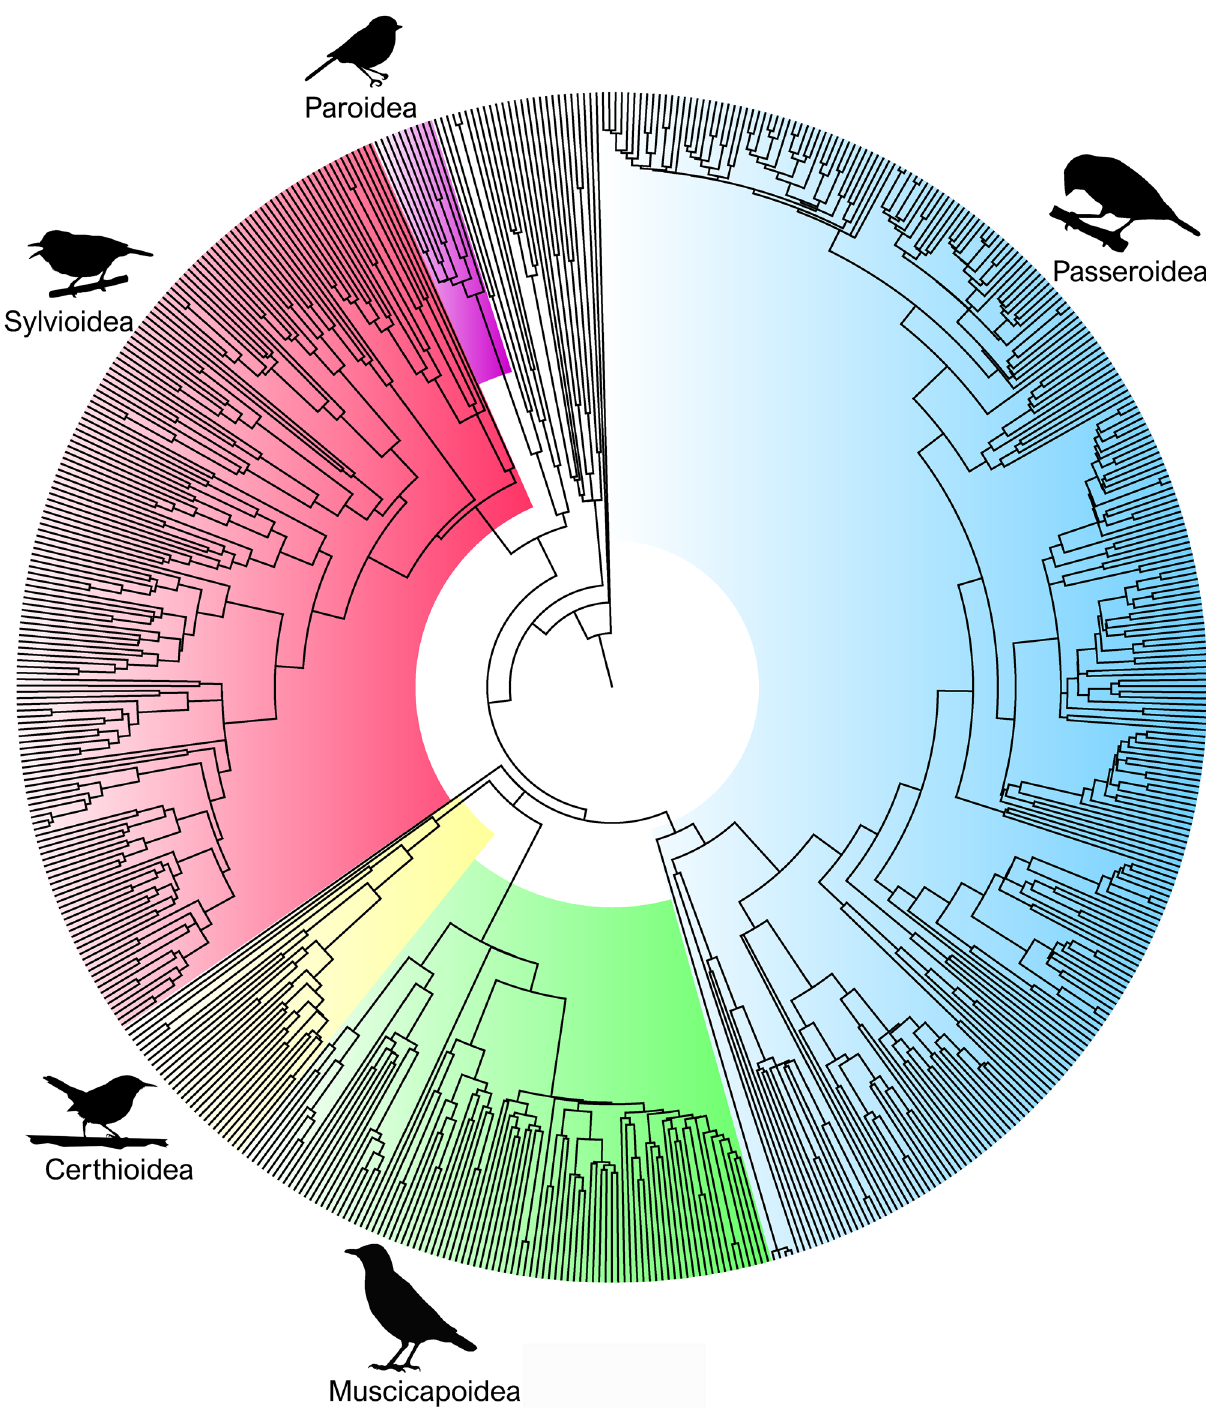
Figure 1. Phylogenetic tree, colored by superfamily. Example of a phylogenetic tree including all studied genera, out of the 1000 trees used to account for shared ancestry. All analyses used Akaike’s information criterion-model averaging across phylogenetic generalized least squares model outputs from these 1000 trees. See the “Supporting information”, Appendix S1, for the assignment of superfamilies. Bird silhouettes, here and in Figs. 2 and 3, are by Ferron Sayol and Matt Wilkins, from phylopics.org, and are in the public domain (creative commons license CC0